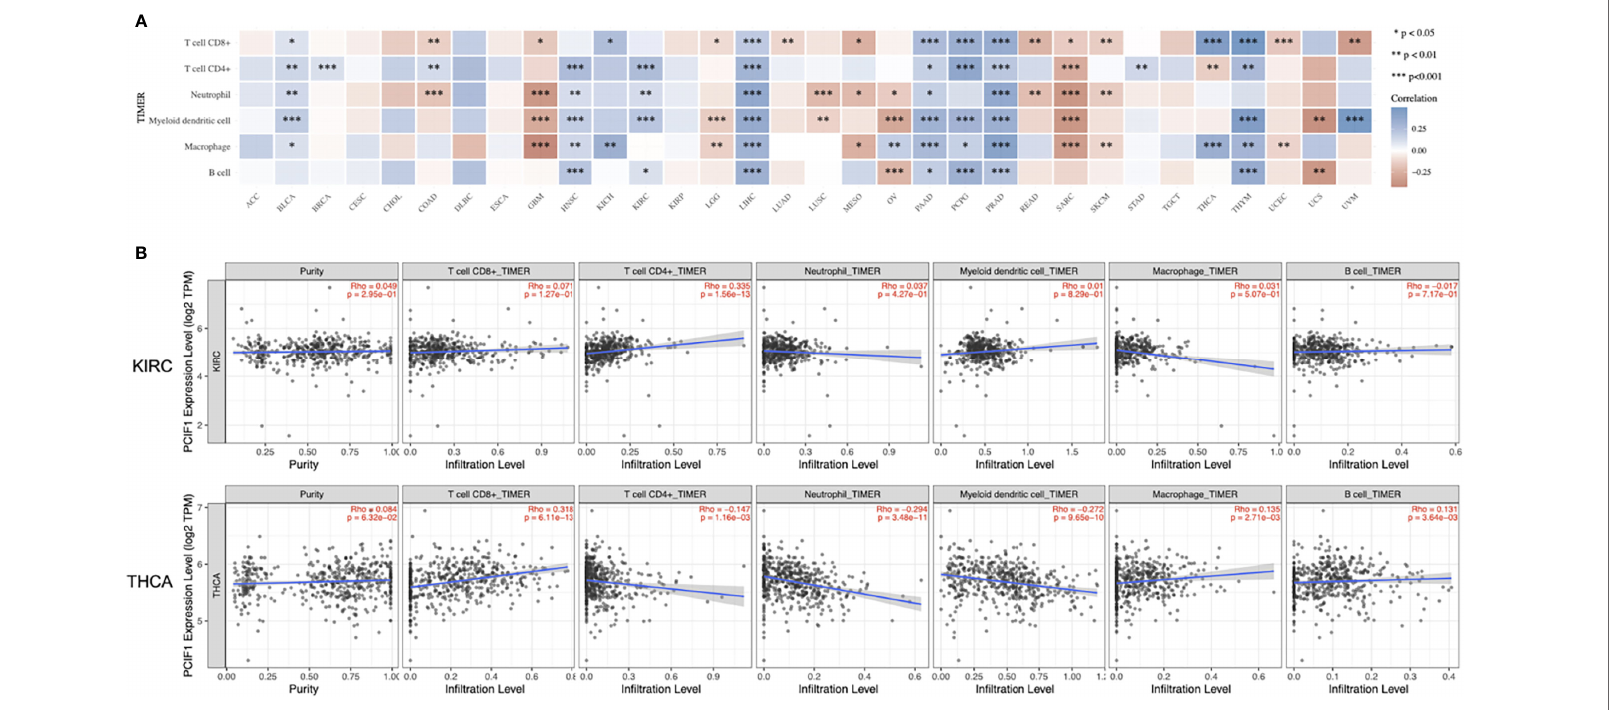
FIGURE 5 | Correlation between PCIF1 and immune in fi ltration. (A) Correlation between PCIF1 and immune in fi ltration of CD8 + T cell, CD4 + T cell, neutrophil, myeloid dendritic cell, macrophage, and B cell. (B) Correlation between PCIF1 and immune in fi ltration in KIRC and THCA. *p < 0.05; **p < 0.01; ***p <